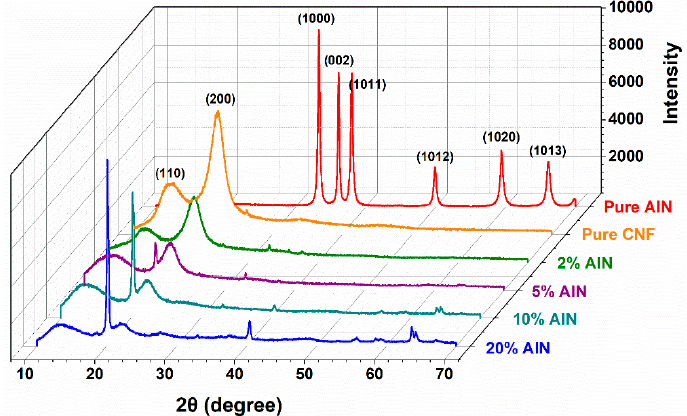
Figure 7. XRD spectra of the pure AlN, pure CNF and CNF-AlN composites.